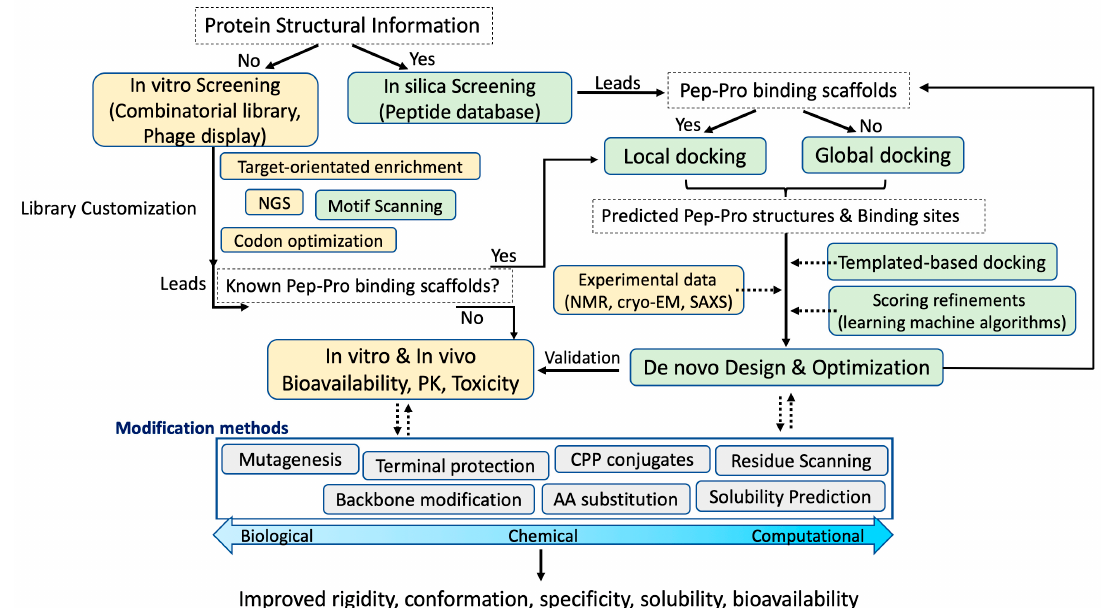
Figure 1. A modular view of the peptide drug development cycle. This flowchart provides a summarized overview for topics covered in this review. Boxes in green color indicate computational methods; gold are biological methods; grey are commonly modification methods applied for improving peptide bioactivity. The blue two-headed arrow represents the modification methods that are relatively more biological, chemical or computational. White dashed boxes are criteria for accessing which method can be chosen next depending on availability of information. Solid or dashed arrows indicate direct or optional connections between methods, respectively.